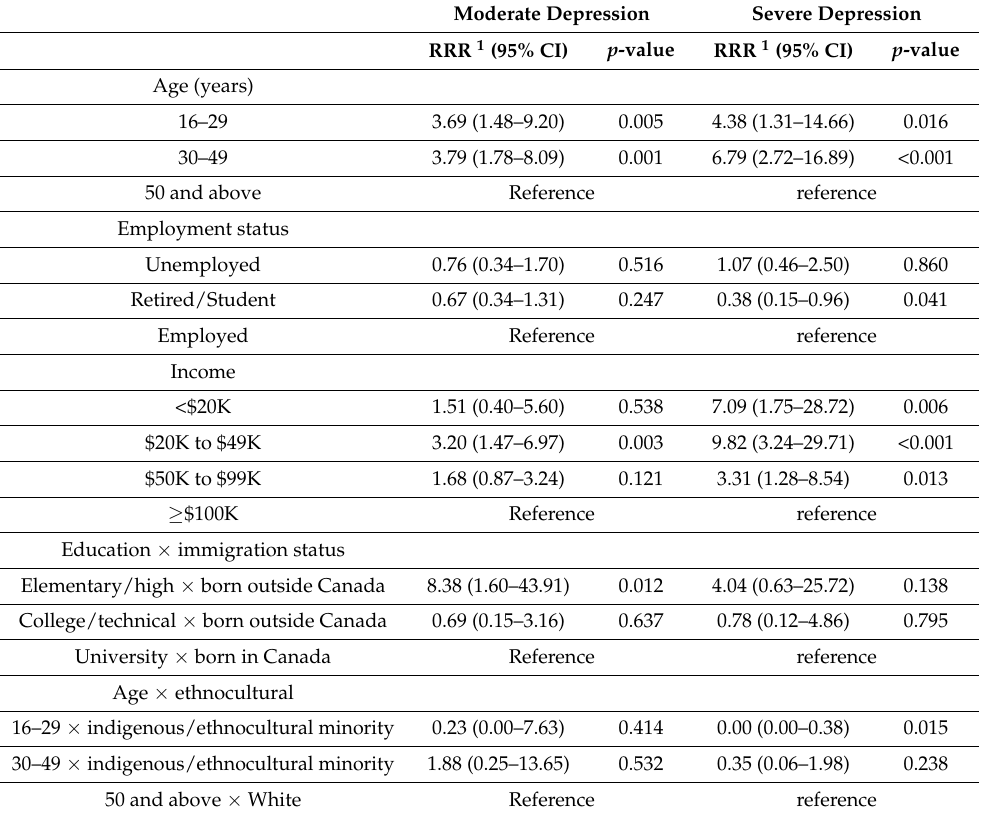
Table 3. Factors associated with self-reported moderate, and severe depression compared to mild depression, cycle 5 MHRC survey (1–8 February 2021),